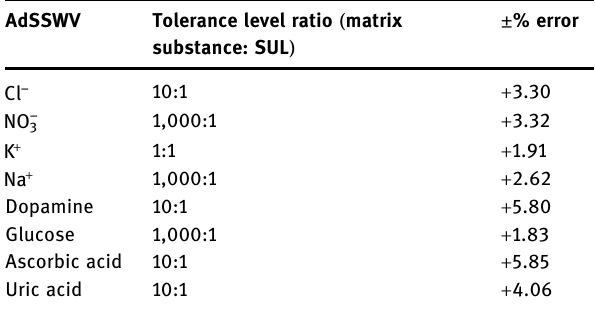
Table 3: Tolerance of interferences on the determination of 1 × 10 − 4 M SUL using GO/ β - CD modi fi ed PGE